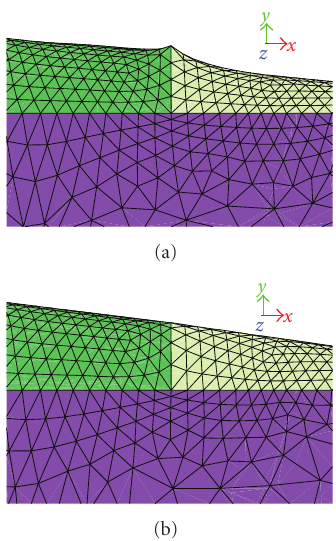
Figure 9: Bump in a channel—surface initial mesh and patches shown in di ff erent colours with one side blanked, viewed from the down side.